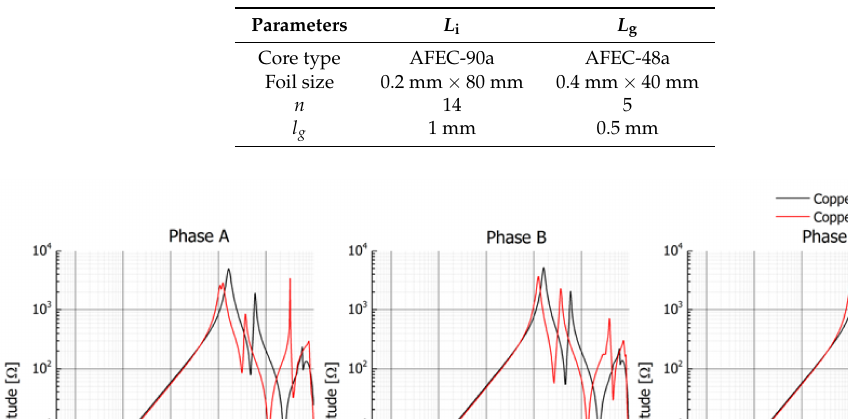
Table 3. Inductor parameters.